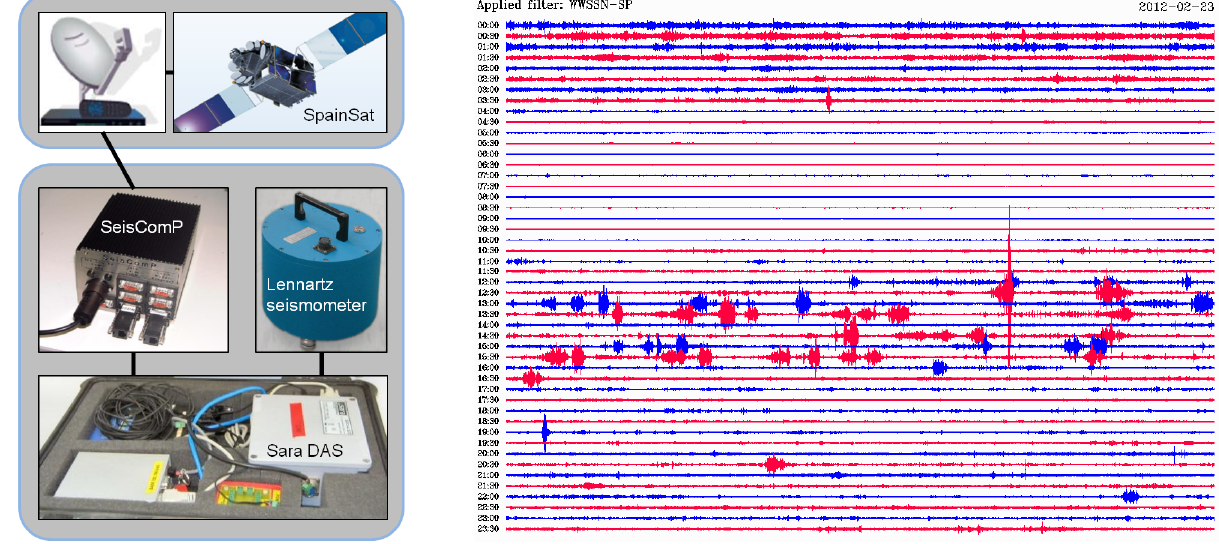
Figure 15. Left: elements of the system designed for satellite transmission of seismic data during the austral winter; right: example of a 24-hour record image generated by SeisComP and transmitted successfully from Deception Island to the IAG-UGR in Spain during a test of the system on February 23,